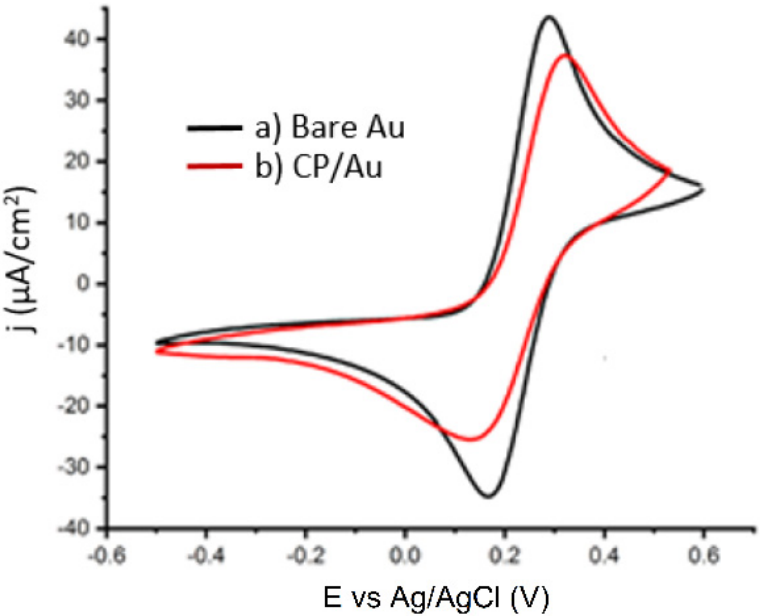
Figure 4. CV of 5.0 mmol · L − 1 Fe(CN) 6 3 − /4 − containing 100 mmol · L − 1 KCl: a ) bare Au, b )